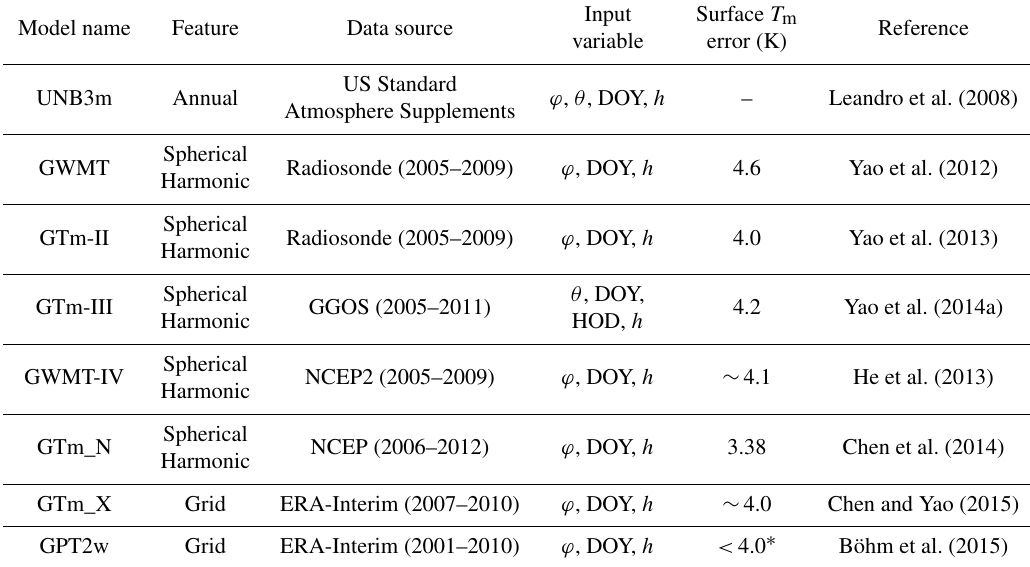
Table 1. A list of the latest global empirical T m models a